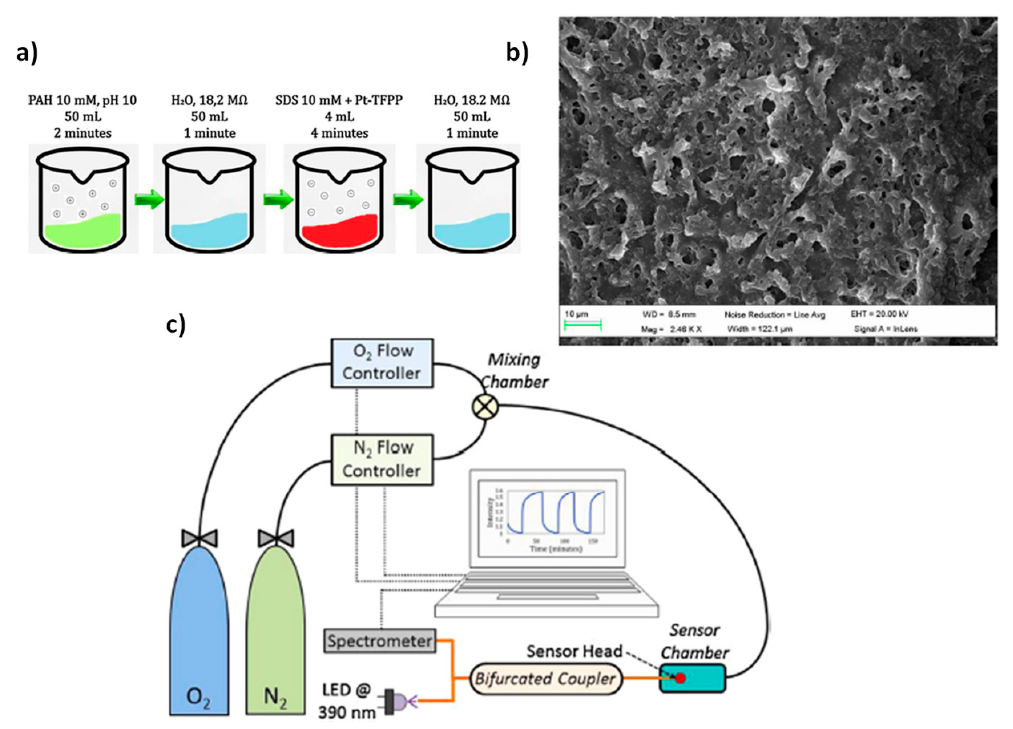
Figure 2. ( a ) Solutions required for the preparation of the Layer-by-Layer films as well as the duration of the immersion steps to construct a cycle; ( b ) SEM image obtained from an optical fiber once the construction process is over; ( c ) Experimental setup used to characterize the sensor. The flow controllers are electronically tuned by software. Reprinted with permission from Ref. [27].